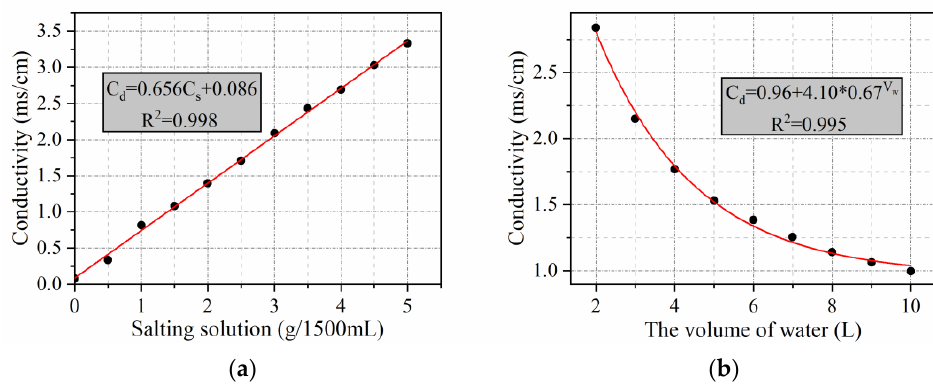
Figure 8. The conductivity of the solution as a function of salt content and water volume: ( a ) relationship between solution conductivity and salt content; ( b ) relationship between solution conductivity and water volume.